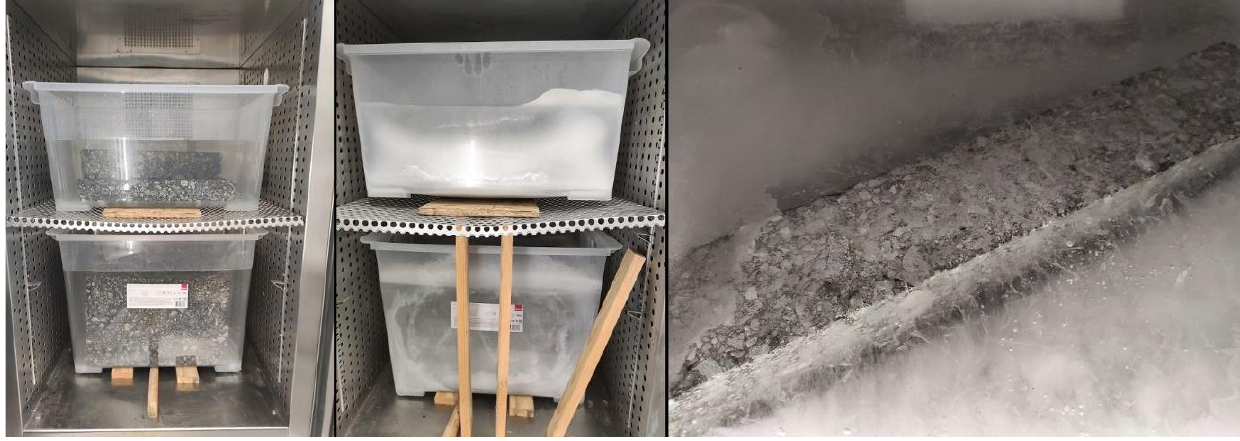
Figure 2. Camber view: water-frost impact.